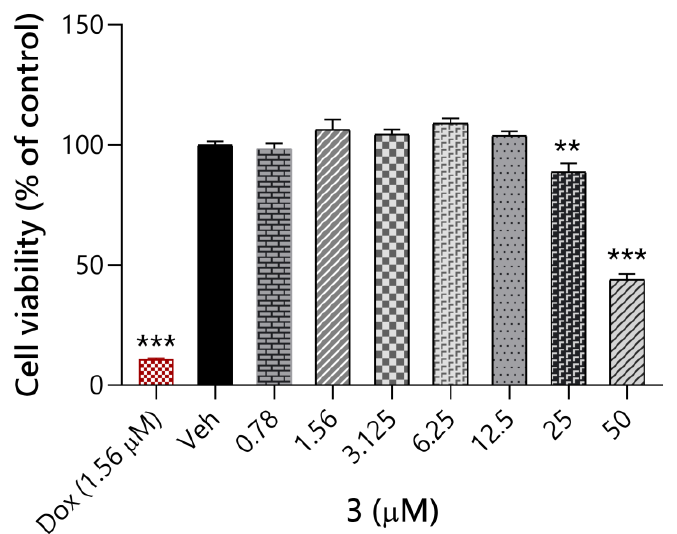
Figure 3. The effect of compound 3 on HepG2 cells’ viability. The graphs were generated using GraphPad Prism software for IC 50 calculations based on MTS data. Each point represents the mean ± SEM of two independent experiments, each of which consisted of three replicates per treatment group and is expressed as a percentage of control cells treated with 0.1% of DMSO (Veh). Doxorubicin (DOX) serves as a common chemotherapeutic agent, which induced hepatotoxicity. All statistical analyses were performed using GraphPad Prism software 8.0. Statistical significance was evaluated via one-way ANOVA with a post-hoc Dunnett test at significance level α = 0.05 (** p = 0.003, *** p < 0.001).